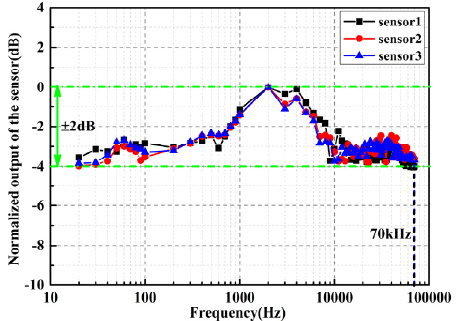
Figure 9. The frequency response curve of the three FOASs.